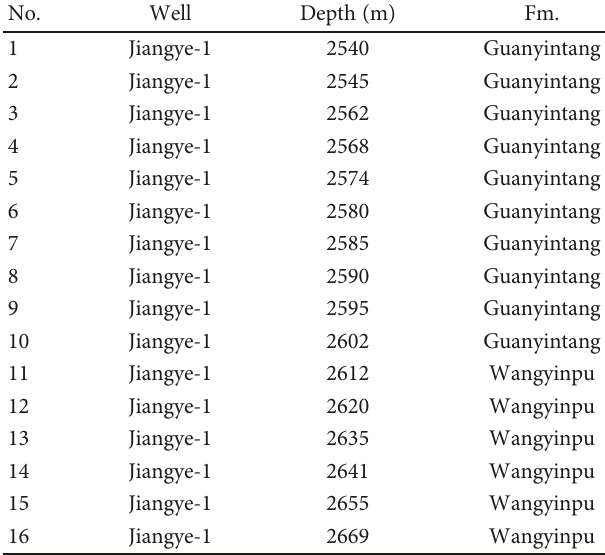
No.=sample number; Fm.=formation.